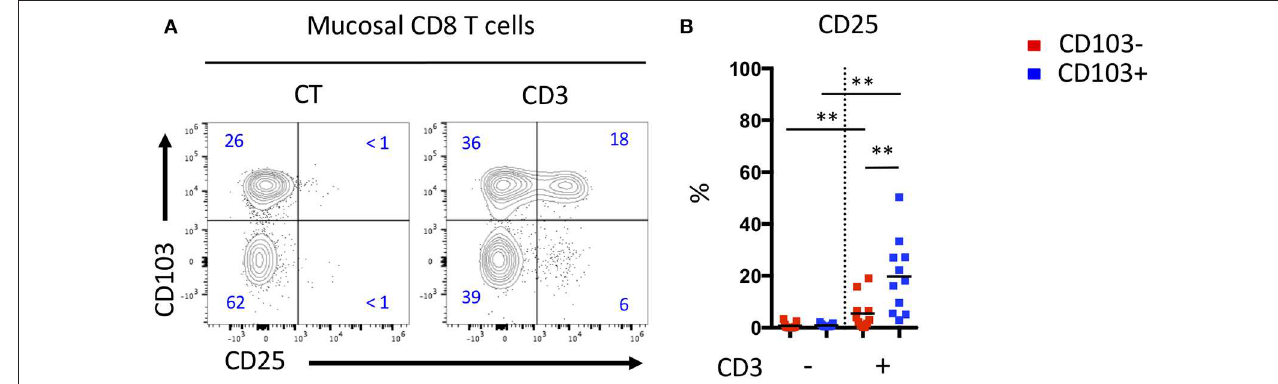
FIGURE 5 | Mucosal CD103 + CD8 T cells from CD patient are more responsive to TCR triggering than CD103- CD8 T cells. (A) Representative expression of CD103 and CD25 activation marker on mucosal CD8T cells from CD patients after TCR triggering. (B) Quantification of CD25 expression on CD103 + and CD103- mucosal CD8T cells from CD patients after TCR triggering ( n = 11, bars represent means, paired t -test, ** p < 0.001).